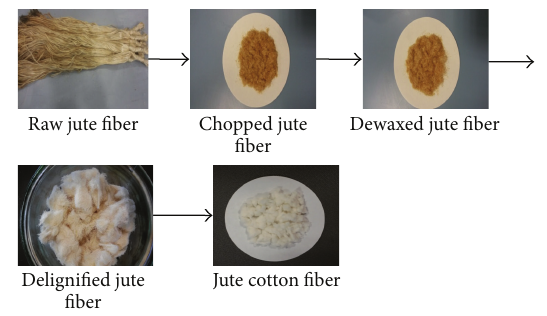
Figure 1: Flow chart of the synthesized jute cotton